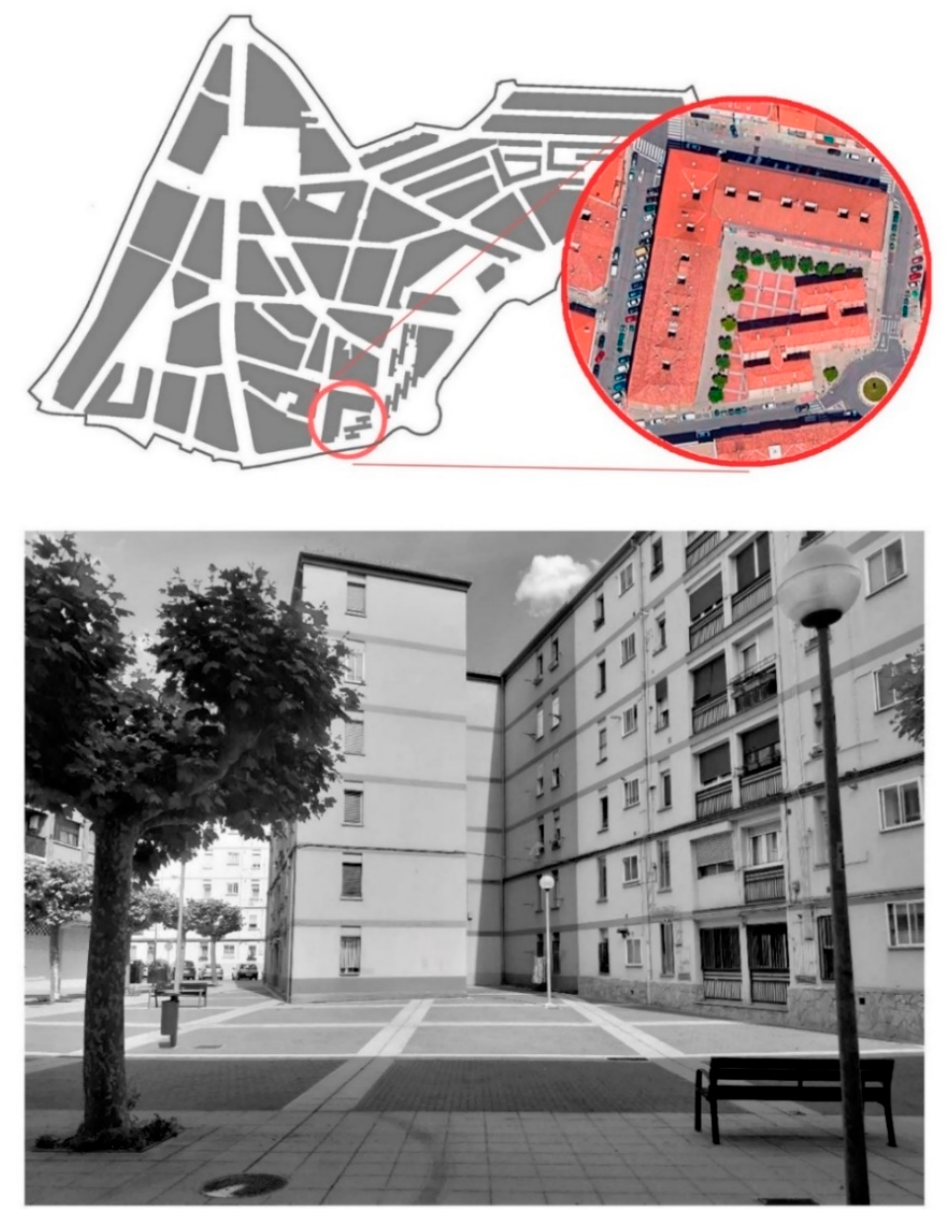
Figure 15. Residual spaces between buildings, resulting of different building typologies. The different building typologies developed in La Milagrosa are open and scattered blocks, some in linear form and others in L, T or H shapes, incapable of giving life and a defined use to the residual spaces that arose between blocks [56]. With groups of massive buildings (known as “polygons”), the very notion of urban layout seemed to disappear [56], and this was a general failure from the point of view of urban quality [55]. These spaces are larger than those between streets, which are more punctual, and cover a total surface area of 39,467.9 m 2 (Table 2). These spaces are currently used as squares (Figure 16) or even car parks (Figure 17), although they were not originally in- tended for that purpose; they were simply undefined remainders between buildings,. The majority, 32,476.2 m 2 , are those destined to be squares, while the car parks occupy 6991.7 m 2 ) (Table